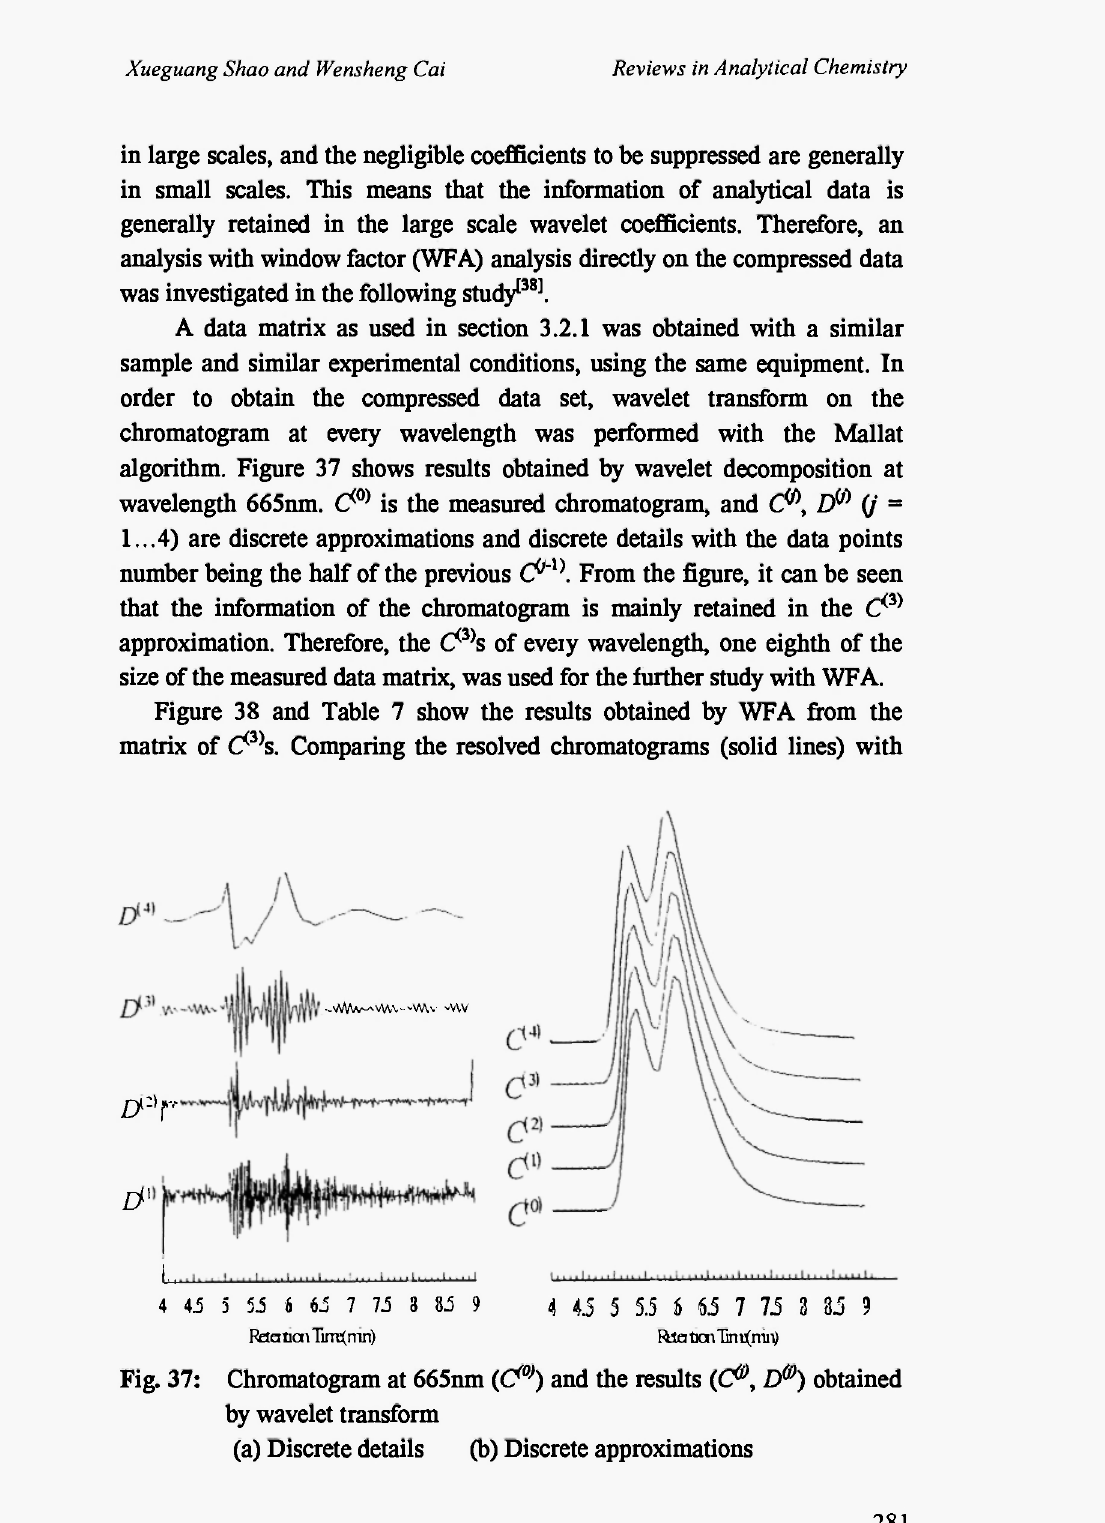
Fig. 37: Chromatogram at 665nm (0 0> ) and the results (C®, D 0> ) obtained by wavelet transform (a) Discrete details (b) Discrete